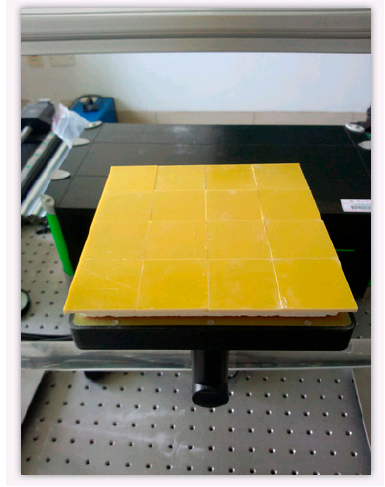
Figure 3. The complete sample with adhesion.